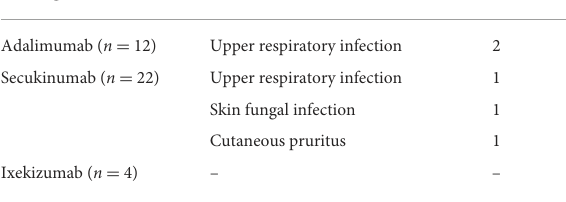
TABLE 2 Adverse events of children with psoriasis treated with